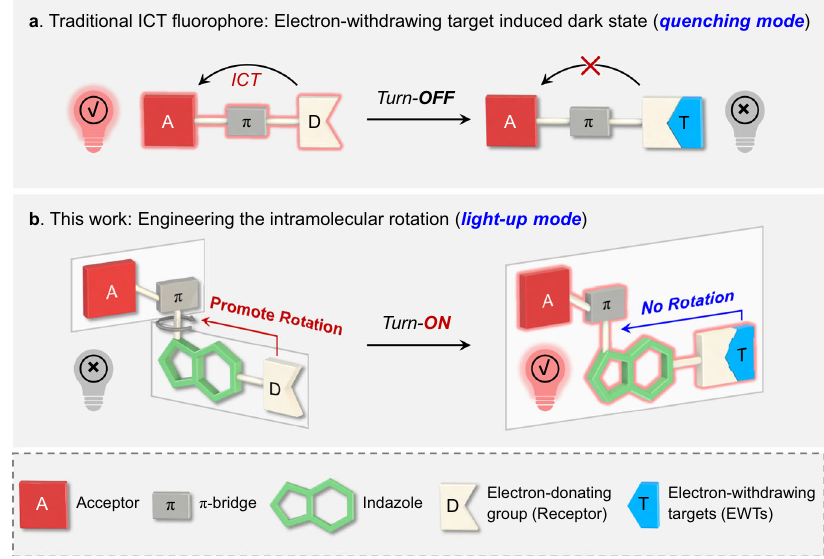
Fig. 1 Fluorescence umpolung of ICT fl uorophores: overturning the quenching mode into light-up mode. a Traditional ICT fl uorophores: electron- withdrawing targets (EWTs)-induced fl uorescence quenching. b In this work, indazole-based ICT fl uorophores enable light-up sensing of EWTs: D- indazole- π -A fl uorophores show obvious intramolecular rotation between indazole and π -bridge, resulting in a dark state (rotation-induced quenching, fl uorescence OFF). Upon the incorporation of EWTs (such as N -acetyltransferases and nerve agents), the resulting EWT-indazole- π -A fl uorophores show no rotation in the photophysical process, leading to a signi fi cant fl uorescence enhancement ( fl uorescence